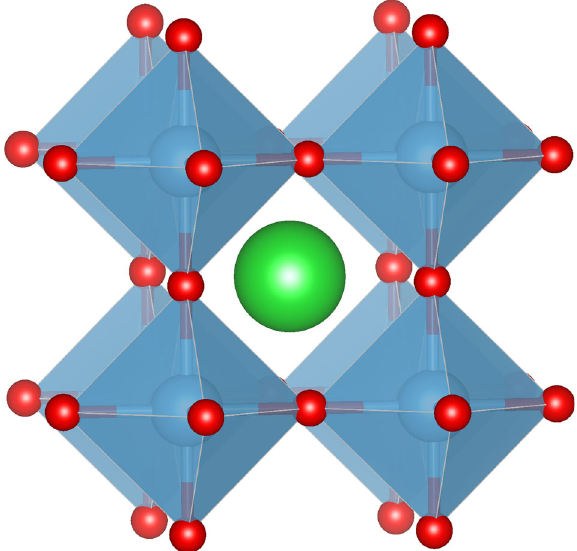
Fig. 10 Perovskite structure with the Wyckoff position 1 a in green, 1 b in blue and 3 c in